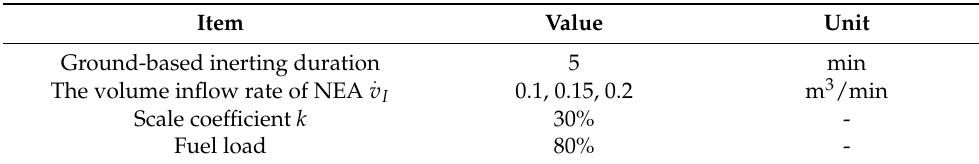
Table 6. The boundary condition of the ullage oxygen concentration analysis regarding the volume inflow rate of NEA. Item Value Unit Ground-based inerting duration 5 . v I The volume inflow rate of NEA